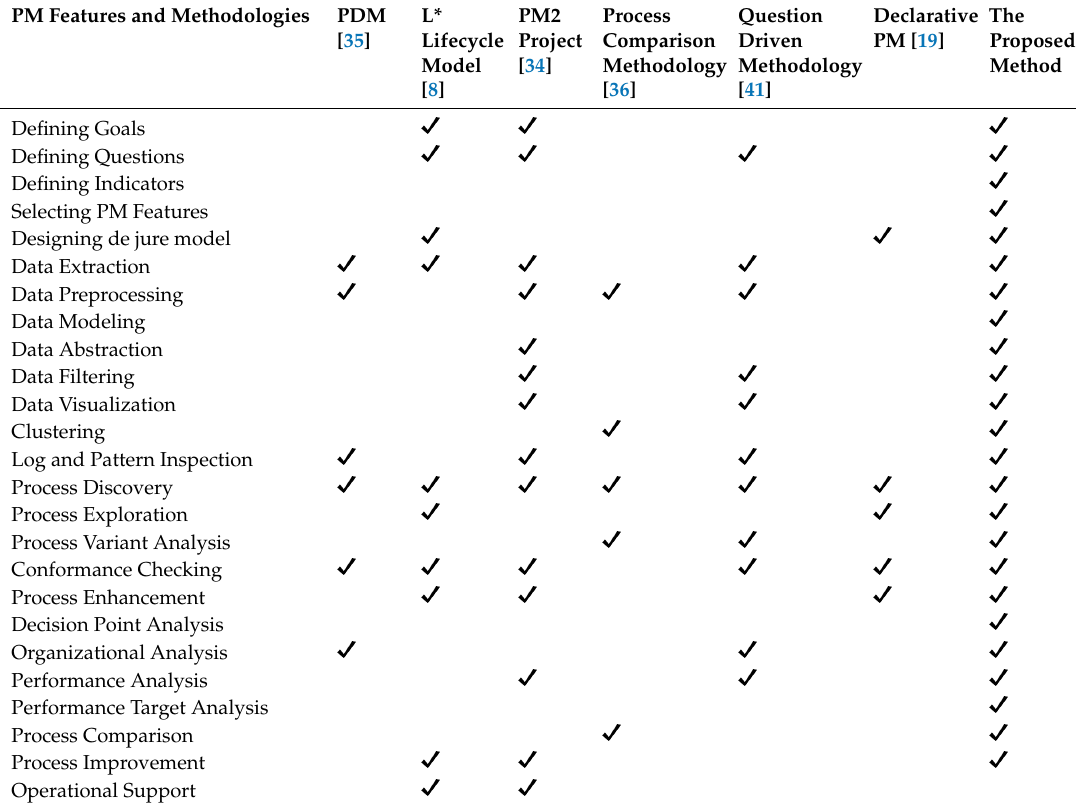
Table 1. PM features of existing methodologies and the proposed